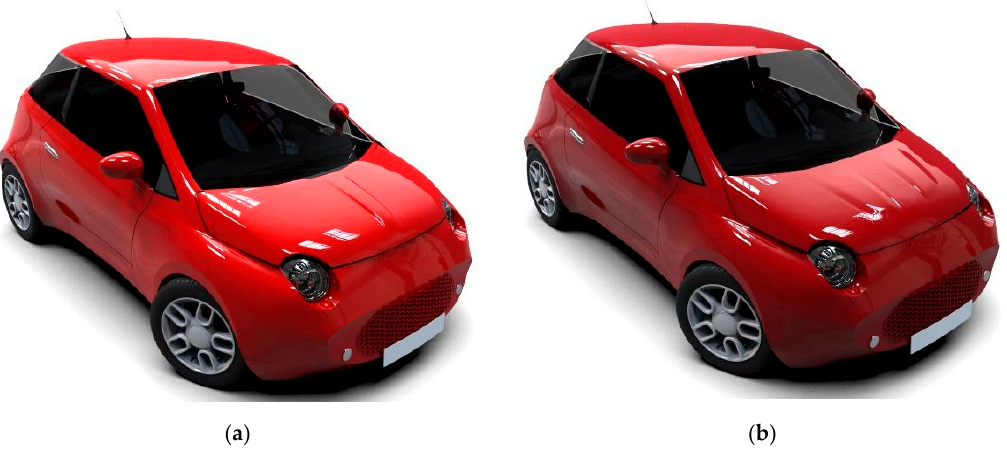
Figure 1. The concept of the EV: ( a ) front hood “A” design, ( b ) front hood “B” design. too and the backside frame dimensions were reduced to decrease the mass of the